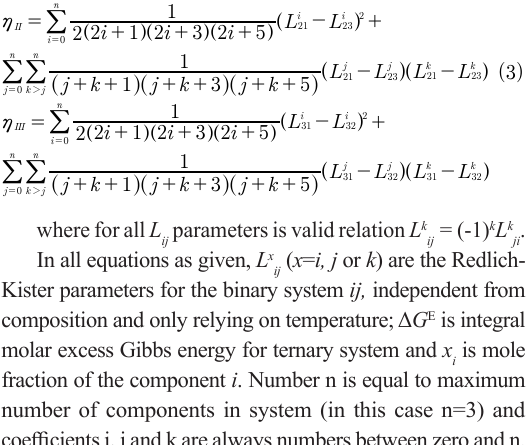
fraction of the component i . Number n is equal to maximum number of components in system (in this case n=3) and coefficients i, j and k are always numbers between zero and n. to the